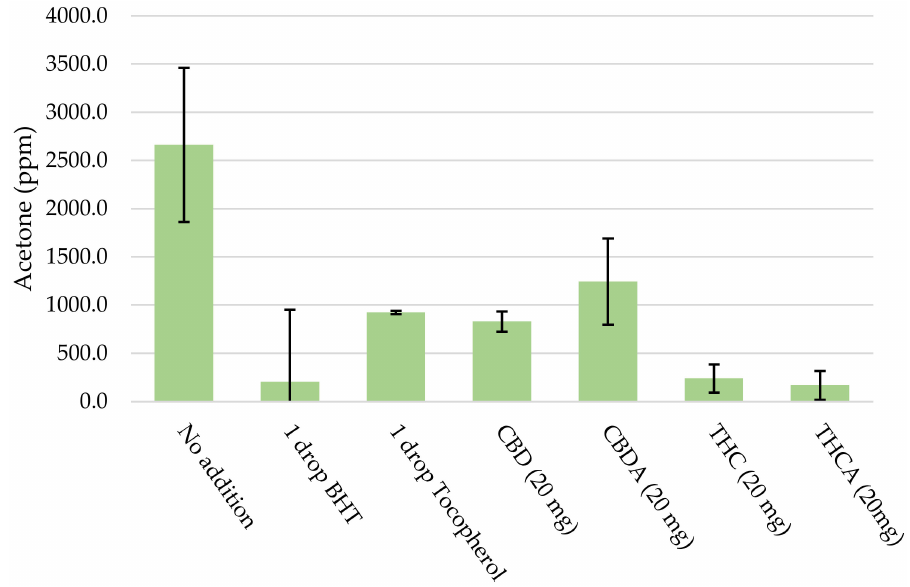
Figure 3. Detection of acetone in samples (PPM) when antioxidants or cannabinoids are present (error bars show the 95% confidence